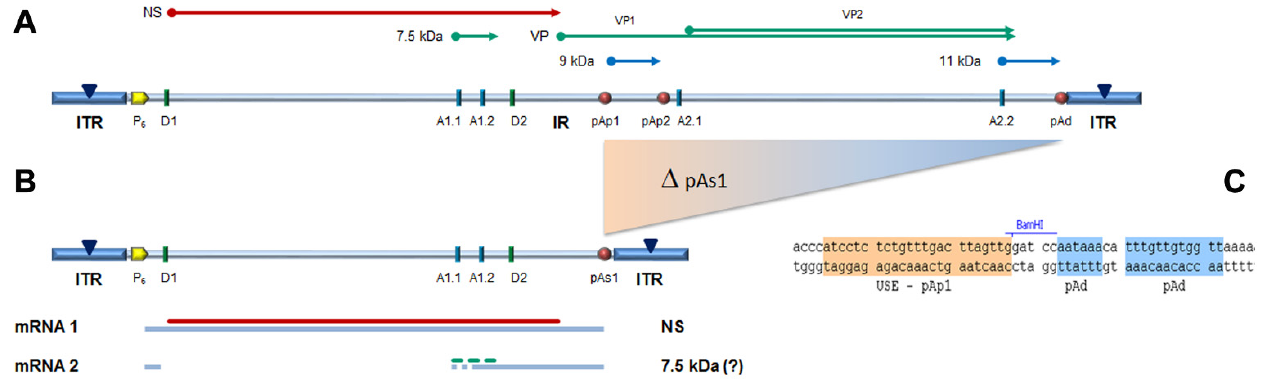
Figure 1. ( A ) Map of B19V genome. ITR: inverted terminal repeats ( (cid:72) , site of dyad symmetry). IR: internal region and relevant cis-acting functional sites (P 6 , promoter; pAp1, pAp2, proximal cleavage-polyadenylation sites; pAd, distal cleavage-polyadenylation site; D1, D2, splice donor sites; A1.1, A1.2, A2.1, A2.2, splice acceptor sites). Coding sequences for viral NS, VP and smaller non-structural proteins are aligned to map. Δ : deletion to create a novel cleavage-polyadenylation signal (pAs1). ( B ) Map of B19V derived minigenome; simplified transcription map, indicating the two classes of mRNAs (mRNA 1–2), with alternative splicing forms (dashed lines) and related coding potential. ( C ) Sequence at the novel pAs1 cleavage-polyadenylation site (USE—pAp1, upstream element to pAp1 [19]).